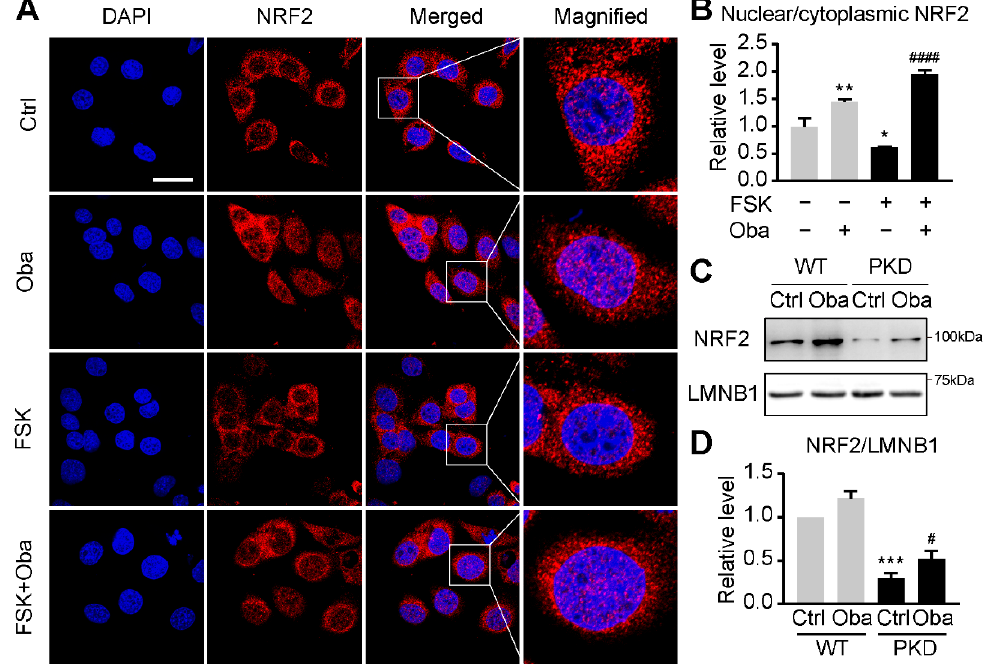
Figure 5. Effect of obacunone on NRF2 activity. ( A ) Immunofluorescence of NRF2 (red) and DAPI (blue) staining in mIMCD-3 cells treated without (Ctrl) or with forskolin (FSK) or obacunone (Oba). Bar = 10 μ m. ( B ) Quantification of fluorescence intensities of NRF2 as in ( A ). n = 12 cells. ( C ) Repre- sentative Western blots of nuclear NRF2 in the kidneys of wild-type (WT) and PKD mice (PKD) treated without or with obacunone. ( D ) Quantification of nuclear NRF2 expression levels as in ( C ). Data are presented as means ± SEM. n = 6. * p < 0.05, ** p < 0.01 versus Ctrl. #### p < 0.0001 versus FSK. *** p < 0.001 versus WT-Ctrl. # p < 0.05 versus PKD-Ctrl.